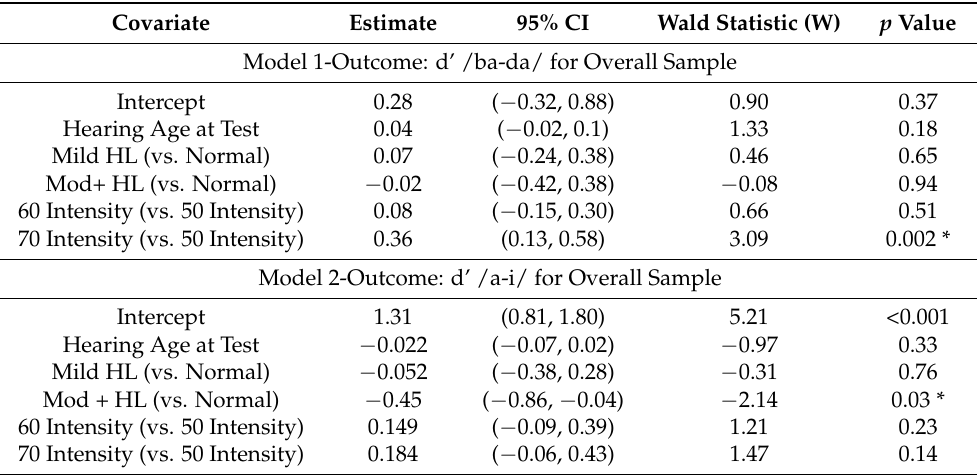
Table 4. Linear regression models for CHH and